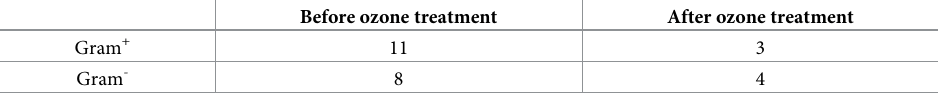
Table 5. Comparison of sensitivity of Gram + and Gram - bacteria to ozone treatment of the waste of rats and mice (bedding), and rabbits and dogs